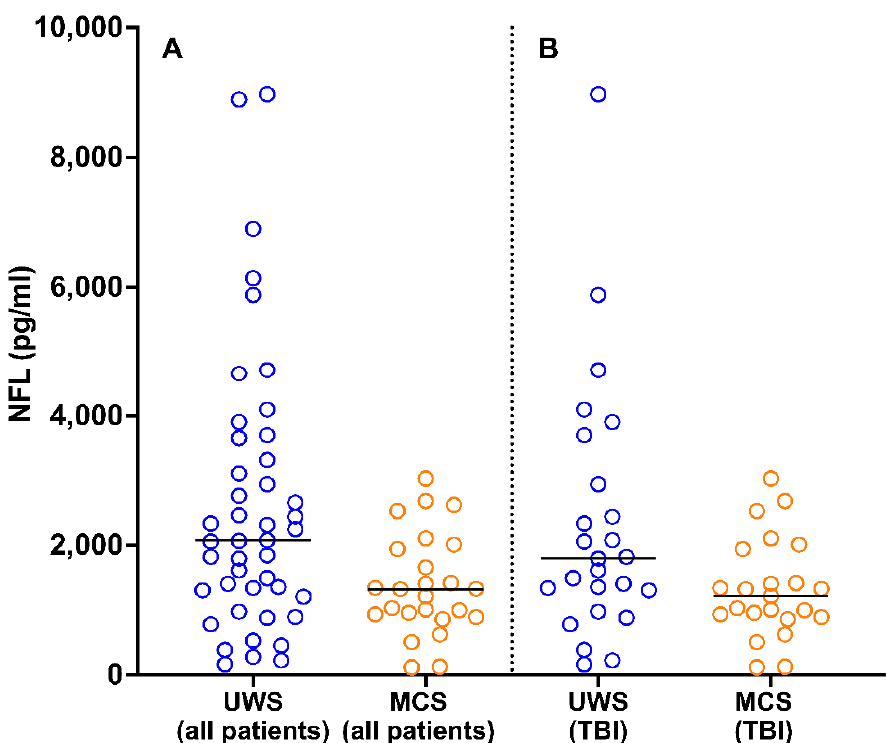
Figure 3. Distribution of NFL values in patients with UWS and MCS in the total sample ( A ) and among patients with TBI ( B ). The horizontal lines indicate median values. One datapoint in the UWS (all patients) group is not reported because it fell outside of the axis limit. NFL, neurofilament light chain; UWS, unresponsive wakefulness syndrome; MCS, minimally conscious state; TBI, traumatic brain injury.